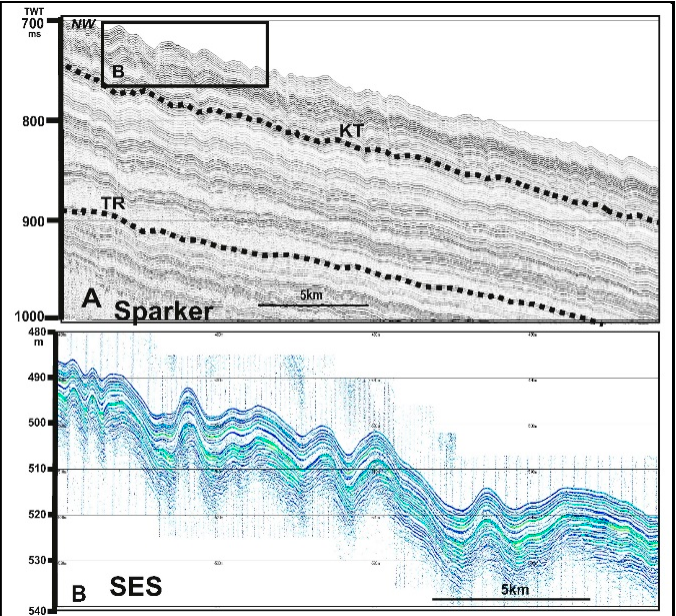
Figure 10. Sediment waves type 3 (contourite) on the northern slope of the Derbent Basin near the Mangyshlak Sill. ( A ) Fragment of the profile (sparker) NW-SE trending across foot of the slope. Main unconformities: TR—Turkanian regression, KT—Khvalinian transgression. ( B ) Enlarged fragment of ultra-high-resolution seismic reflection profile (SES) showing in detail uppermost sedimentary layer. Location of the profiles is shown in Figures 2 and